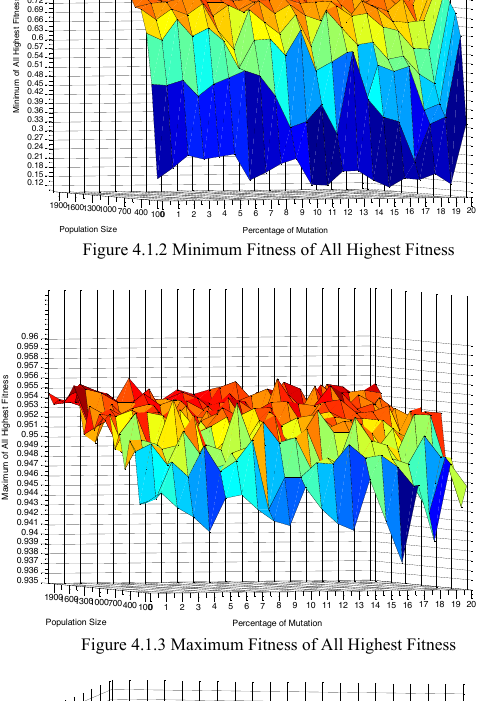
Figure 4.1.3 Maximum Fitness of All Highest Fitness